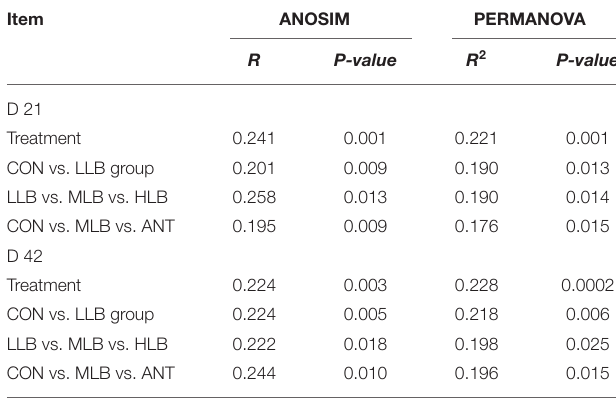
TABLE 4 | ANOSIM and PERMANOVA analysis of microbial diversity among different treatments 1 .